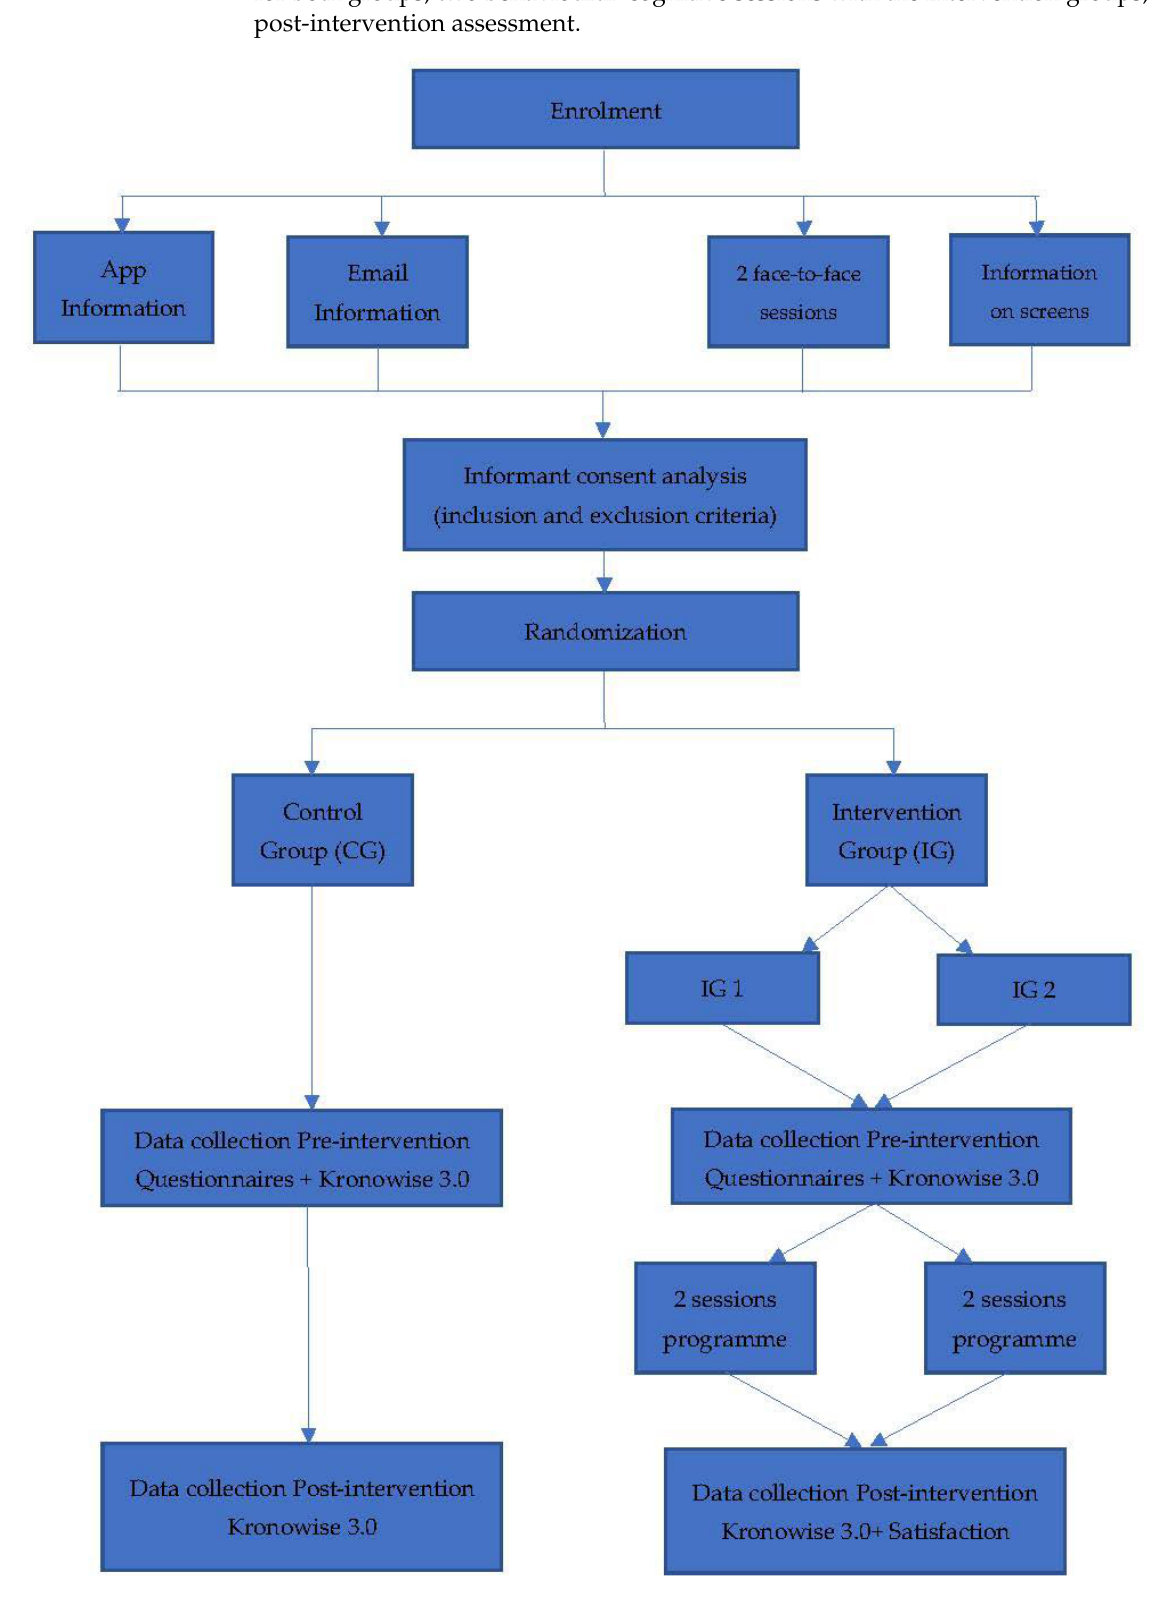
Figure 2. Study procedure.